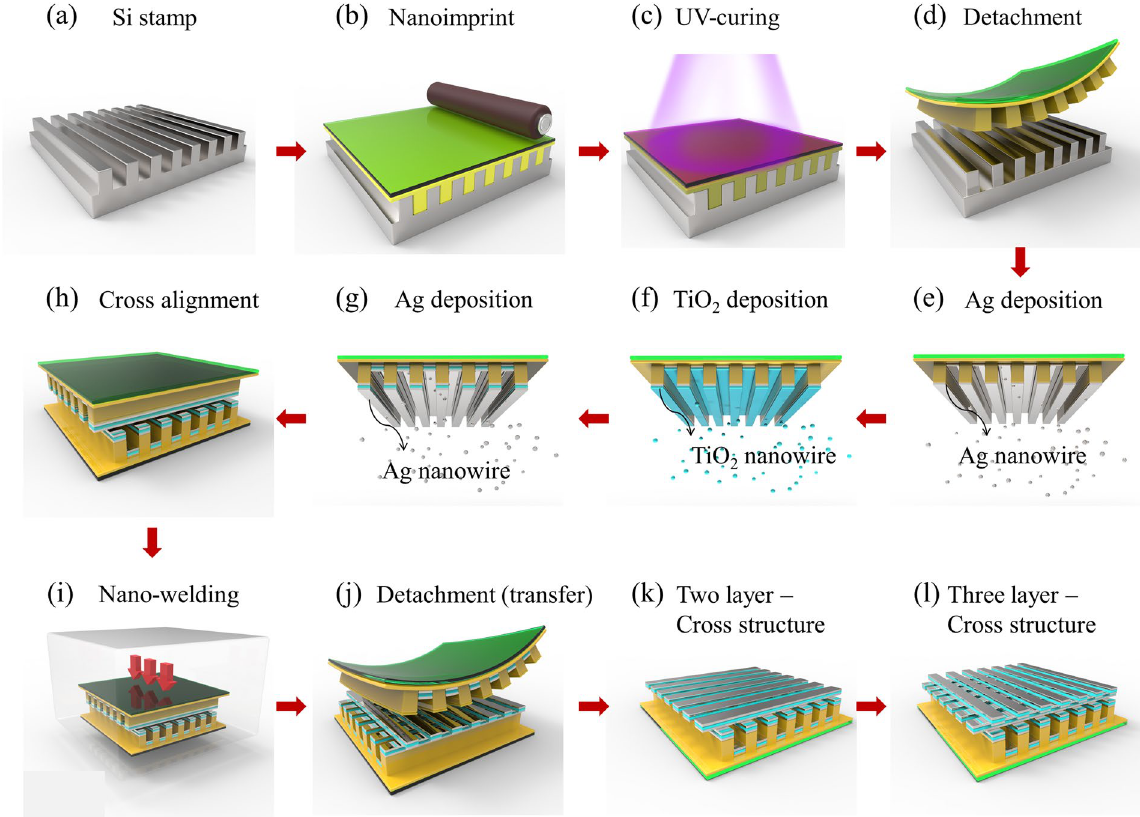
Figure 2. Schematic of fabrication process for Ag/TiO 2 nanocomposite architecture: ( a ),( b ) Formation process of nanocomposite wires with polymer pattern on PMMA film substrate based on nanoimprint lithography; ( c ),( d ) UV-curing for 180 s and stamp detachment; ( e )–( g ) Formation of Ag/TiO 2 nanocomposite wires by E-beam evaporator; ( h ),( i ) Cross alignment and nanowelding process of Ag/TiO 2 nanocomposite wires at the temperature of 90 °C, 0.5 MPa pressure, for 10 min under vacuum state; ( j ),( k ) Detachment process and formation of Ag/TiO 2 nanocomposite cross architecture with two layers; ( l ) Formation of Ag/TiO 2 nanocomposite cross architecture with three layers by repeating process shown in ( i ),( j